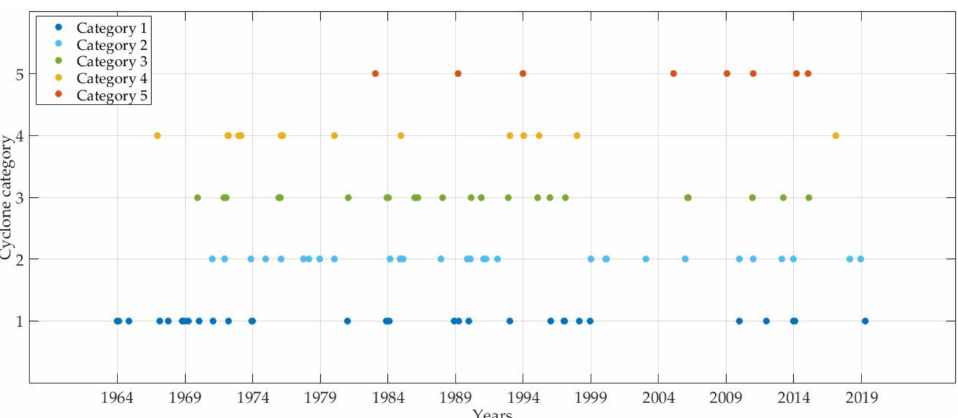
Figure 5. Cyclones passing by the GBR and their corresponding categories.